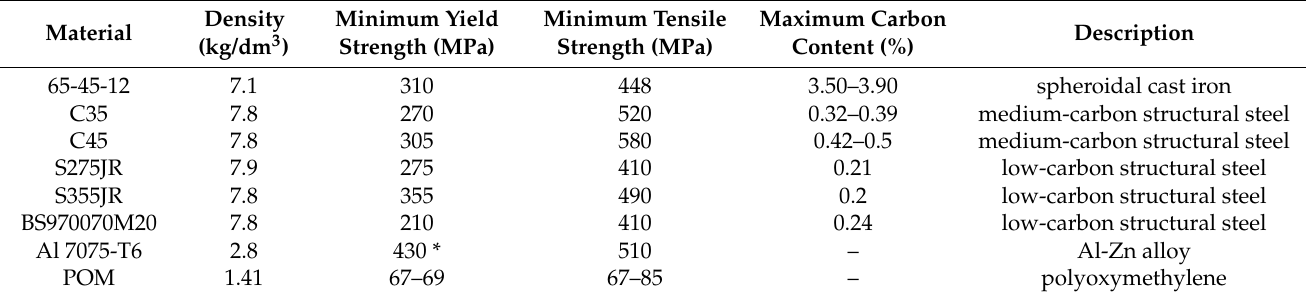
Table 3. Basic properties of the materials used for